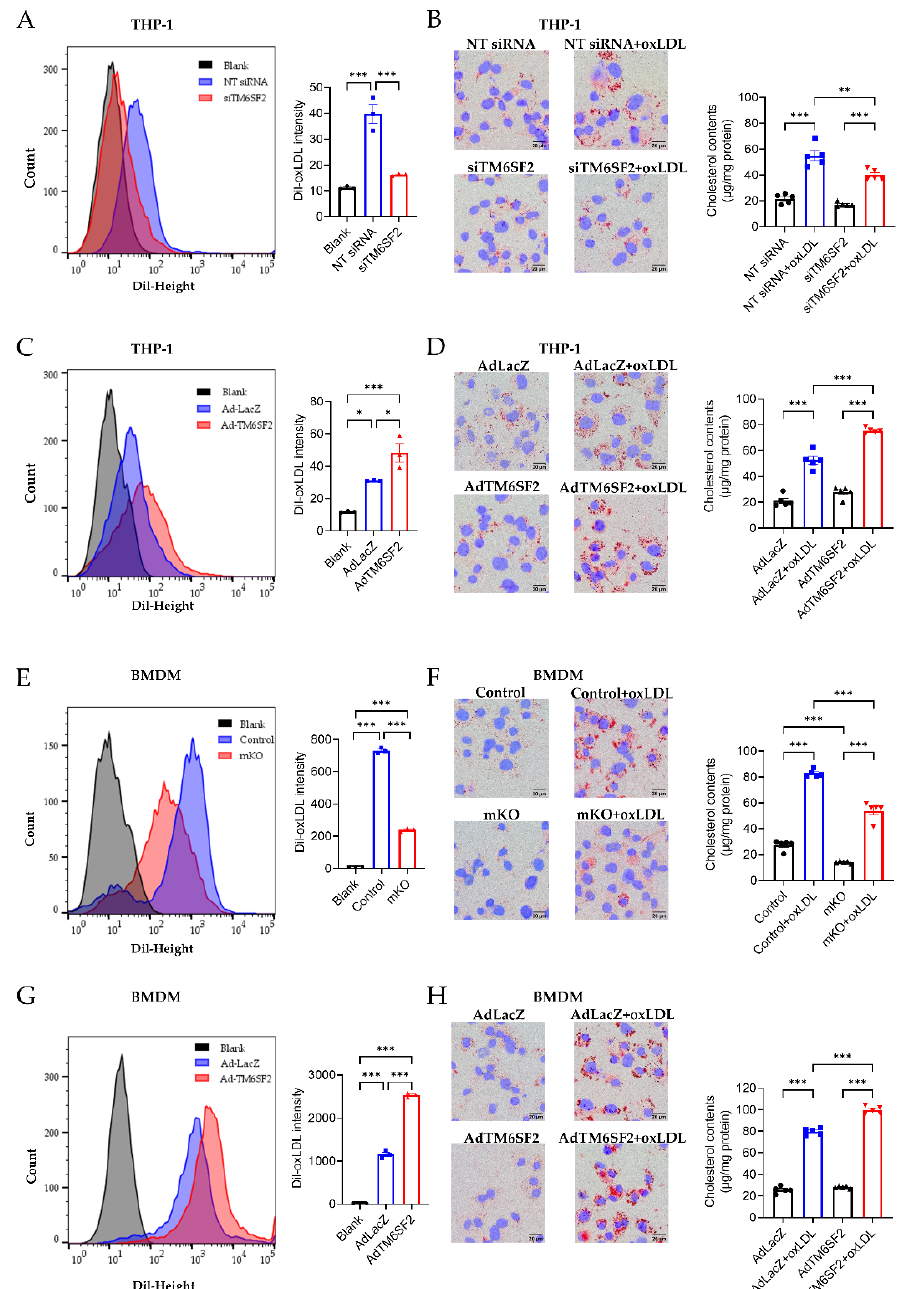
Figure 4. TM6SF2 contributes to foam cell formation. Macrophages were loaded with 5 µg/mL Dil-oxLDL at 37 °C for 40 min and collected for flow cytometry to detect the cholesterol uptake. Macrophages were loaded with 100 µg/mL oxLDL overnight at 37 °C and foam cell formation was determined by Oil Red O staining and the cellular cholesterol content (normalized to total protein). ( A , B ) THP-1-derived macrophages were transfected with NT siRNA or TM6SF2 siRNA (20 nM) for 48 h and treated with oxLDL (100 µg/mL) overnight. ( C , D ) THP-1-derived macrophages were transfected with AdLacZ or AdTM6SF2 (100 MOI) for 48 h and treated with oxLDL (100 µg/mL) overnight. ( E , F ) BMDMs were isolated from control and mKO mice and treated with oxLDL (100 µg/mL) overnight. ( G , H ) BMDMs were isolated from wild-type C57BL/6J mice and were transfected with AdLacZ or AdTM6SF2 (100 MOI) for 48 h and treated with oxLDL (100 µg/mL) overnight. n = 3 for flow cytometry, n = 5 for cholesterol contents detection. All data are presented as mean ± SEM, statistics by ordinary one-way ANOVA. * p < 0.05, ** p < 0.01, *** p < 0.001 as indicated.